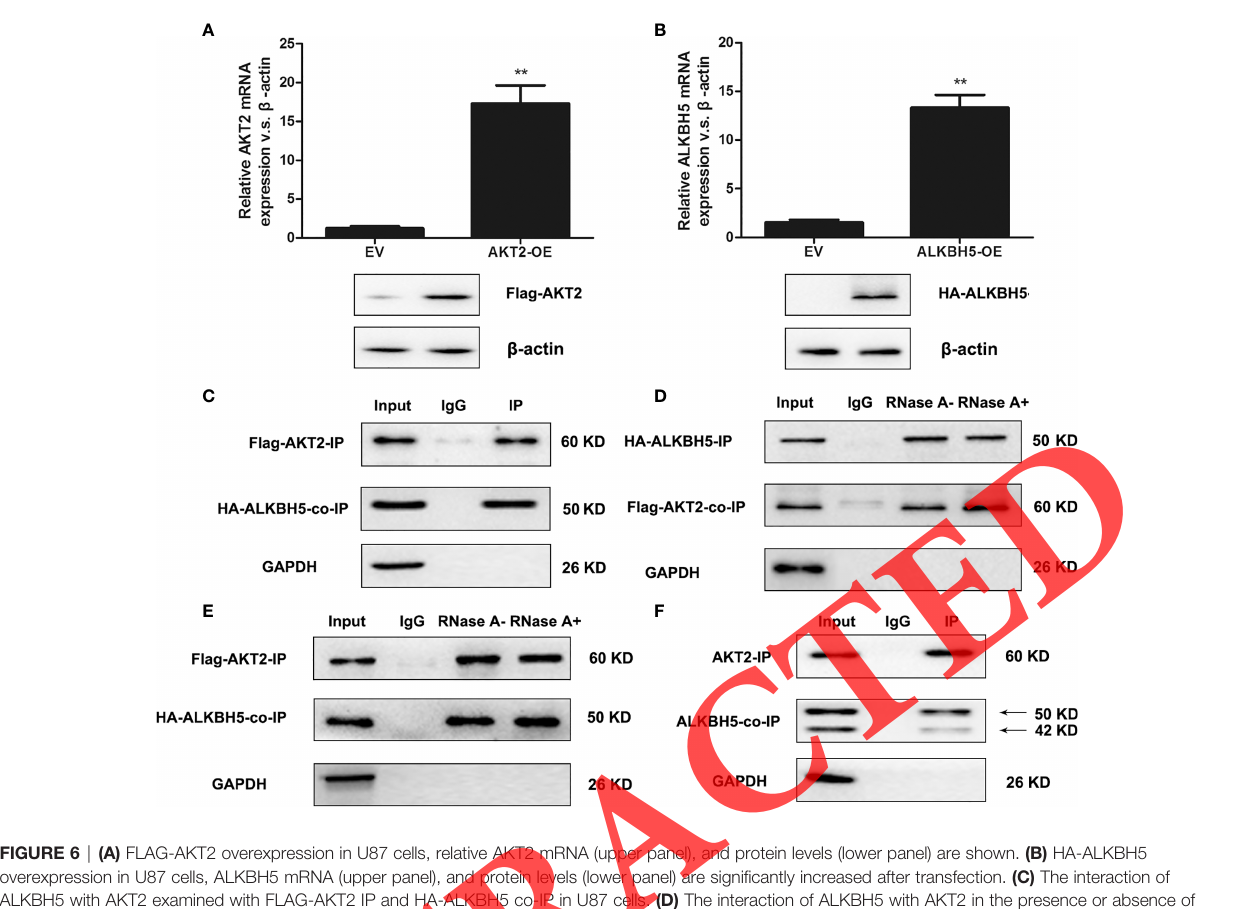
FIGURE 6 | (A) FLAG-AKT2 overexpression in U87 cells, relative AKT2 mRNA (upper panel), and protein levels (lower panel) are shown. (B) HA-ALKBH5 overexpression in U87 cells, ALKBH5 mRNA (upper panel), and protein levels (lower panel) are signi fi cantly increased after transfection. (C) The interaction of ALKBH5 with AKT2 examined with FLAG-AKT2 IP and HA-ALKBH5 co-IP in U87 cells. (D) The interaction of ALKBH5 with AKT2 in the presence or absence of RNase A, examined with HA-ALKBH5 IP and FLAG-AKT2 co-IP in U87 cells. (E) The interaction of ALKBH5 with AKT2 in the presence or absence of RNase A, examined with FLAG-AKT2 IP and HA-ALKBH5 co-IP in U87 cells. (F) Endogenous AKT2 interacted with endogenous ALKBH5, examined with IP and co-IP; two known isoforms of ALKBH5 are indicated with arrowheads. IP and co-IP were performed in triplicates, and representative results are shown. EV, empty vector; OE, overexpression. **P <